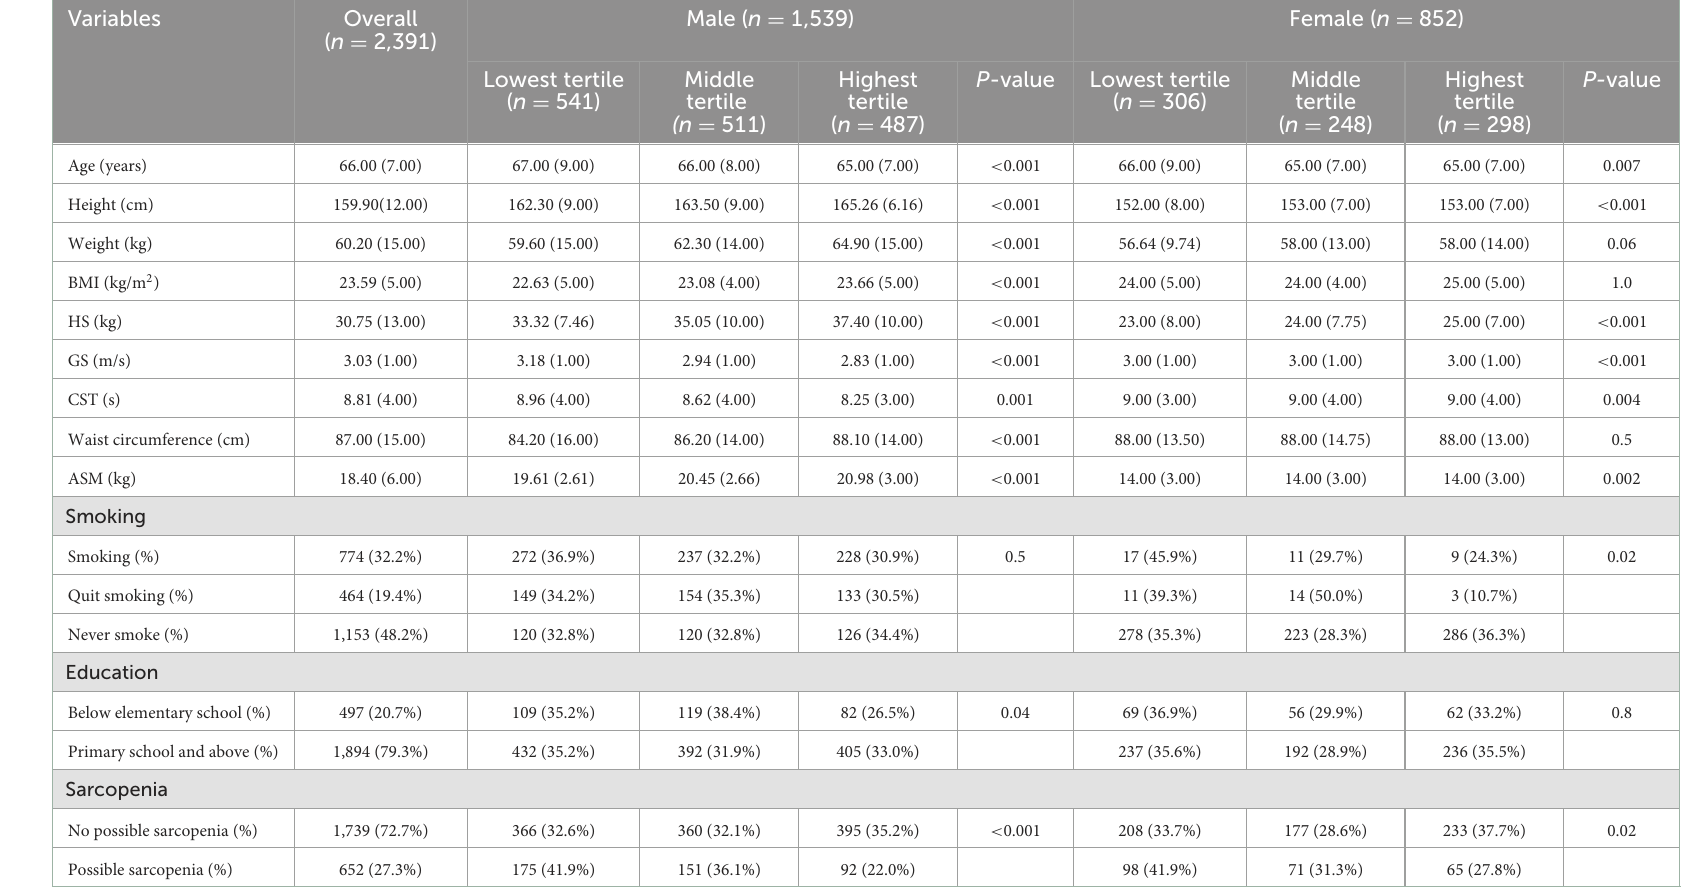
TABLE 2 Characteristics of study participants classified by Cognitive score ( n =